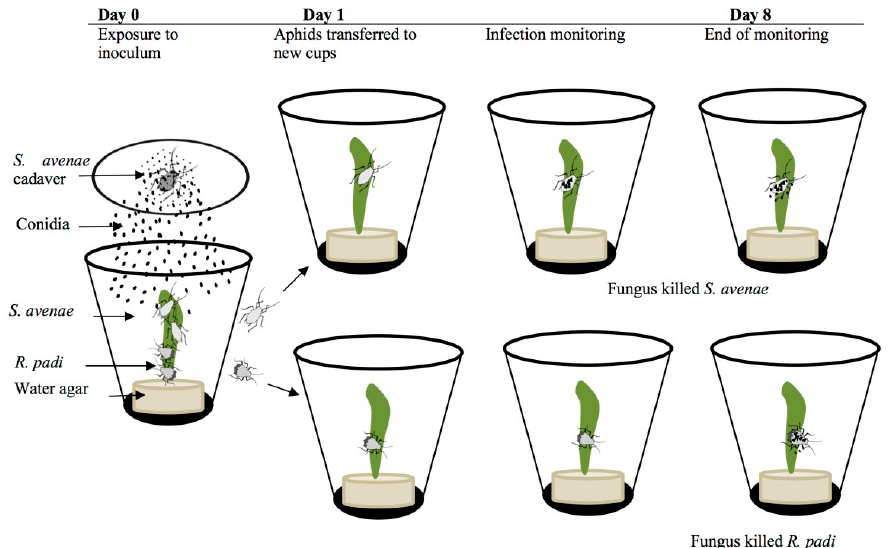
Figure 1. Inoculation and monitoring procedure of the aphids Sitobion avenae and Rhopalosiphum padi exposed to the fungi Pandora neoaphidis or Entomophthora planchoniana using the conidia shower method. Ten specimens of each of the two aphid species were infected in the same cup simultaneously to ensure they were exposed to same conidia concentration.